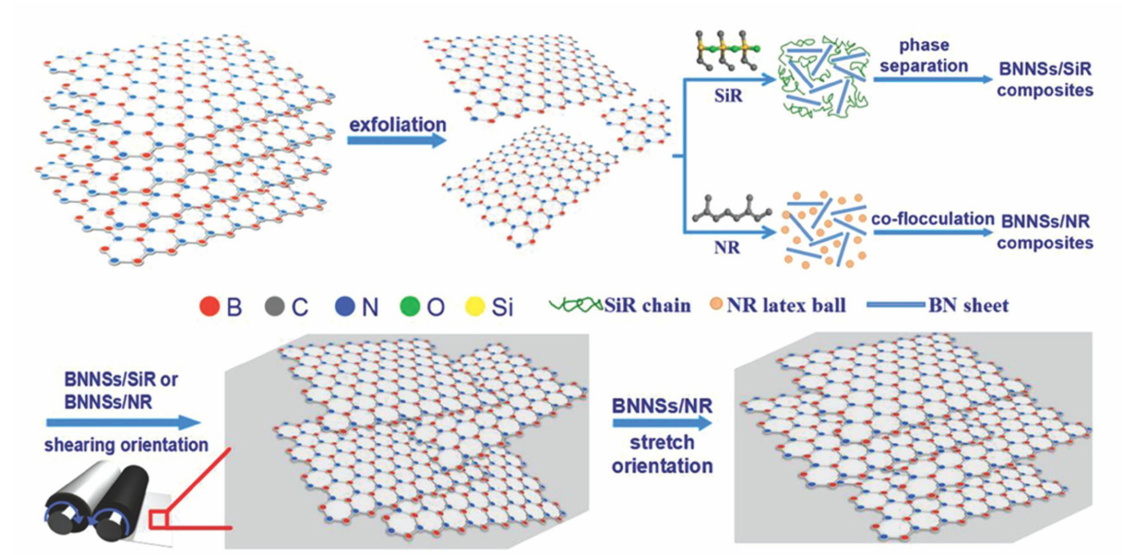
Figure 12. Scheme of the preparation of BNNSs/SiR and BNNSs/NR nanocomposites [171]. Copyright© 2014 WILEY-VCH Verlag GmbH & Co. KGaA, Weinheim. All rights reserved.